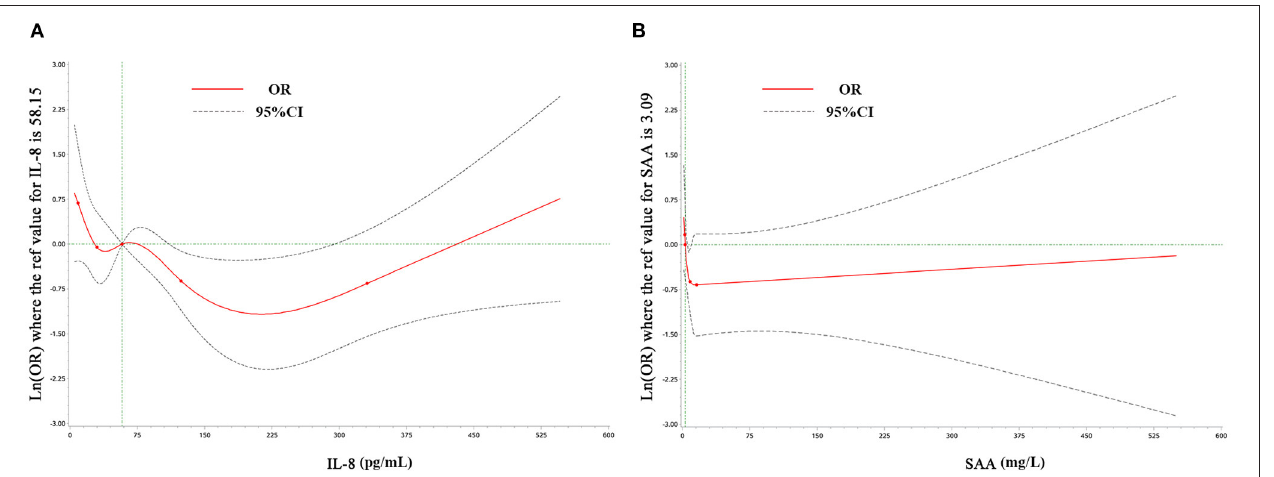
FIGURE 1 | Examination of the relationship between IL-8 (A) , SAA (B) , and anxiety symptoms by restricted cubic splines analysis. Odds ratios are represented by the solid red line and the 95% confidence interval by the dotted